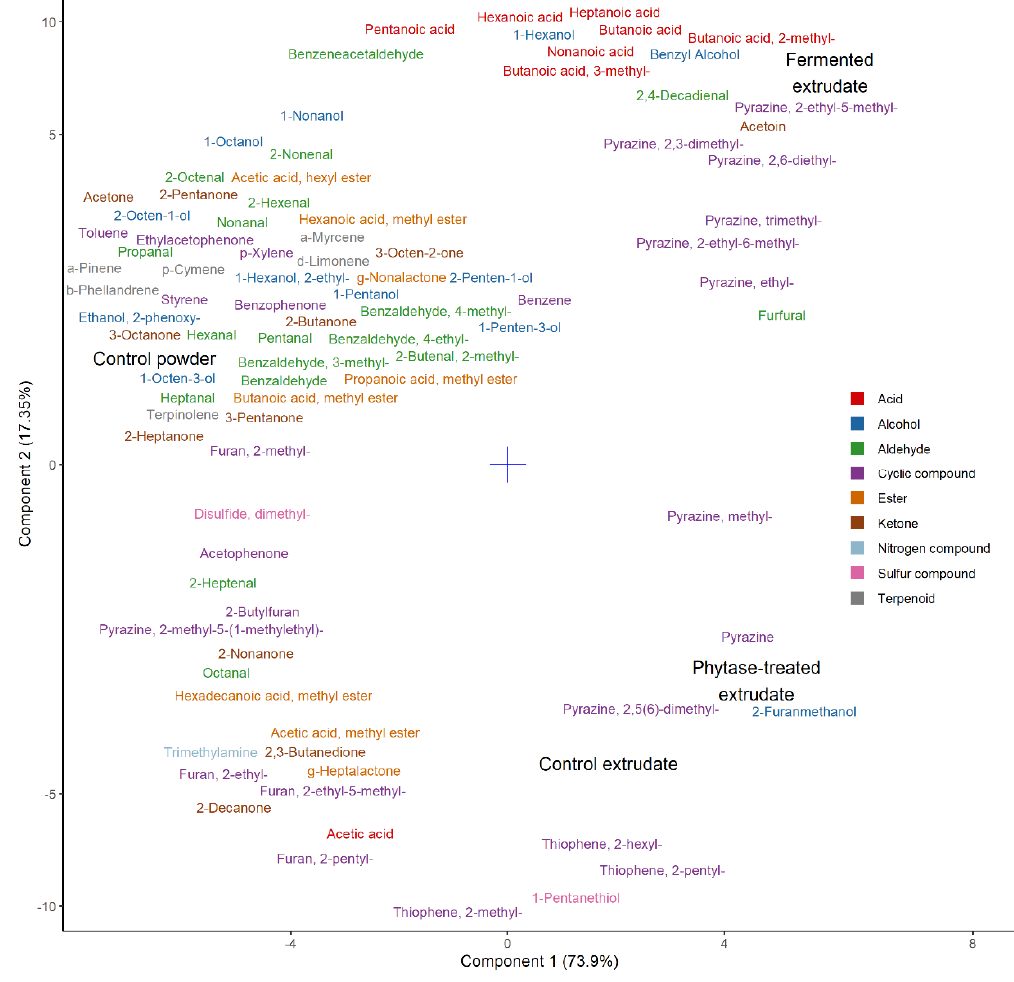
Figure 6. Partial least squares discriminant analysis of gas chromatography data. The number in parenthesis indicates variance captured by the principal component.